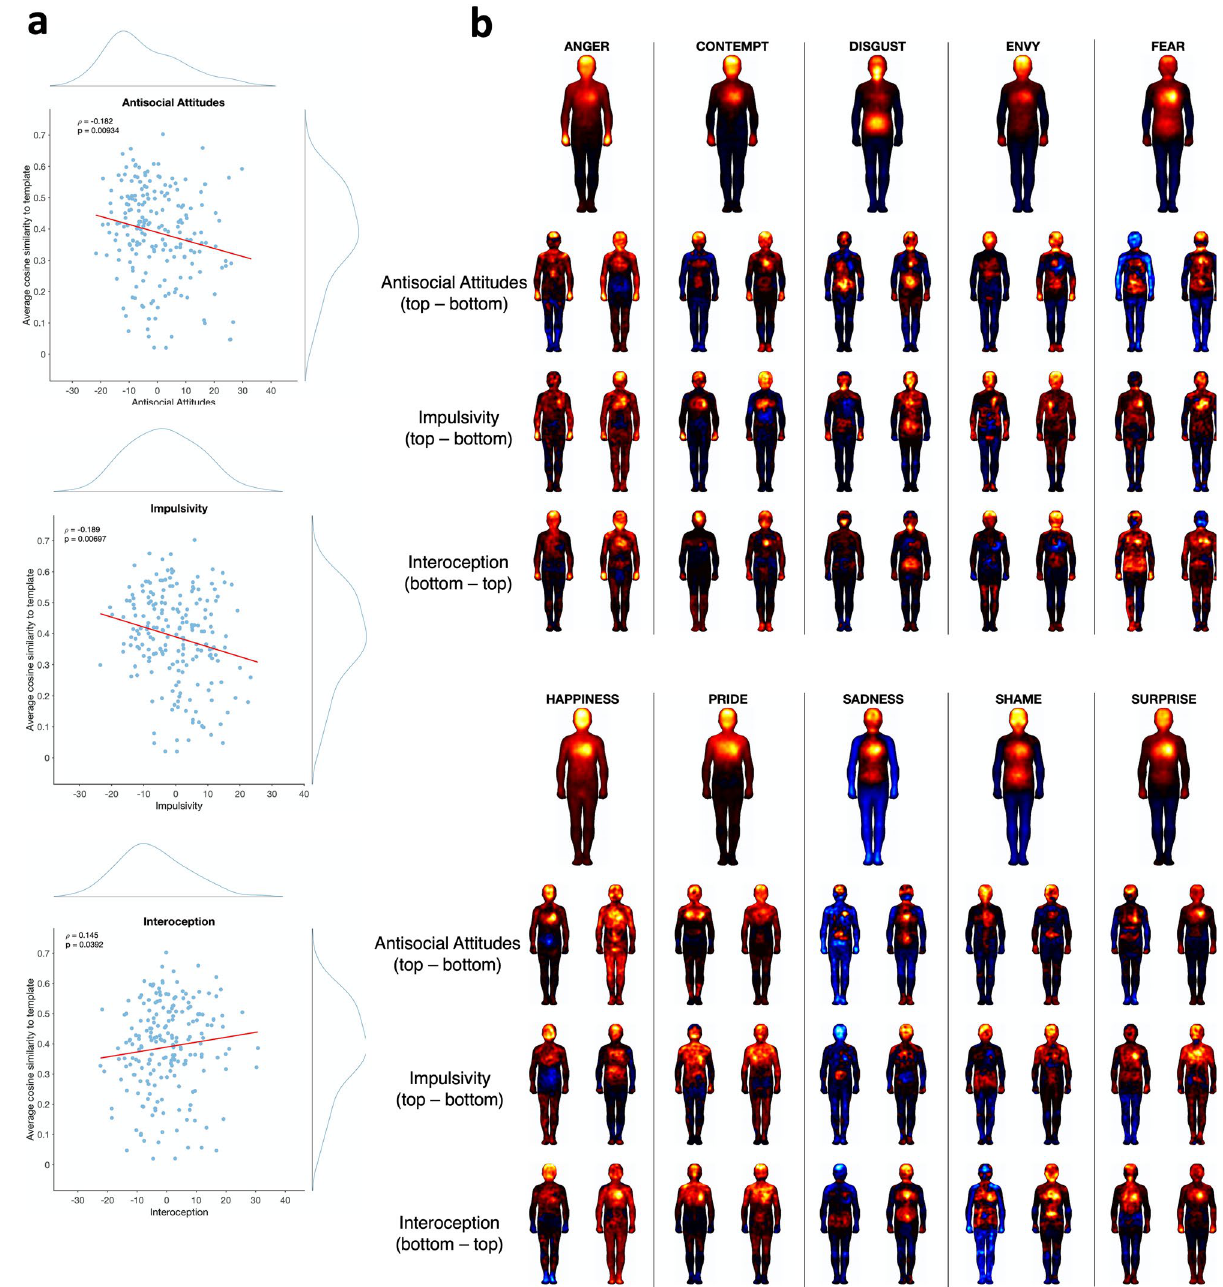
Figure 4. Relationship of body map representativeness and differentiation with personality PCA components. ( a ) Correlations of BSM representativeness with personality PCA components; Spearman’s ρ and the corresponding p value are plotted. Histograms show the distribution of each variable. ( b ) Average body maps for the bottom 5% and top 5% of each personality factor (empathy, interoception: bottom 5% on the left, top 5% on the right; impulsivity: top 5% on the left, bottom 5% on the right). Group average maps are shown